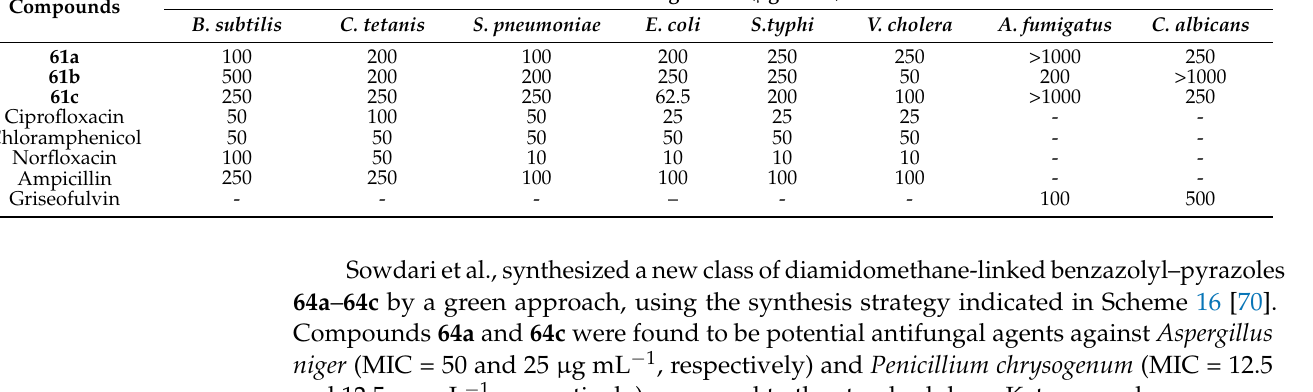
Table 5. In vitro antimicrobial activity of benzimidazole–pyrazoles 61a – 61c .